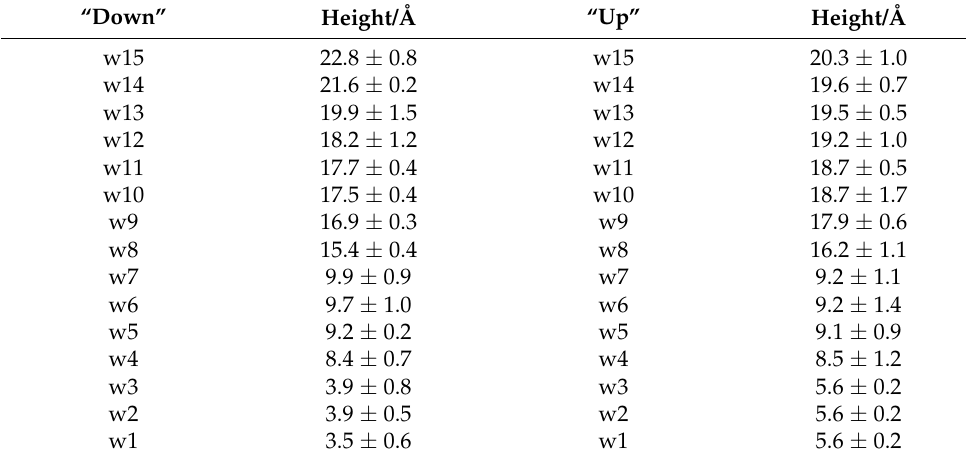
Table 1. Average positions (as measured by the height in cylinder) of the protonated water molecule in the different simulations.